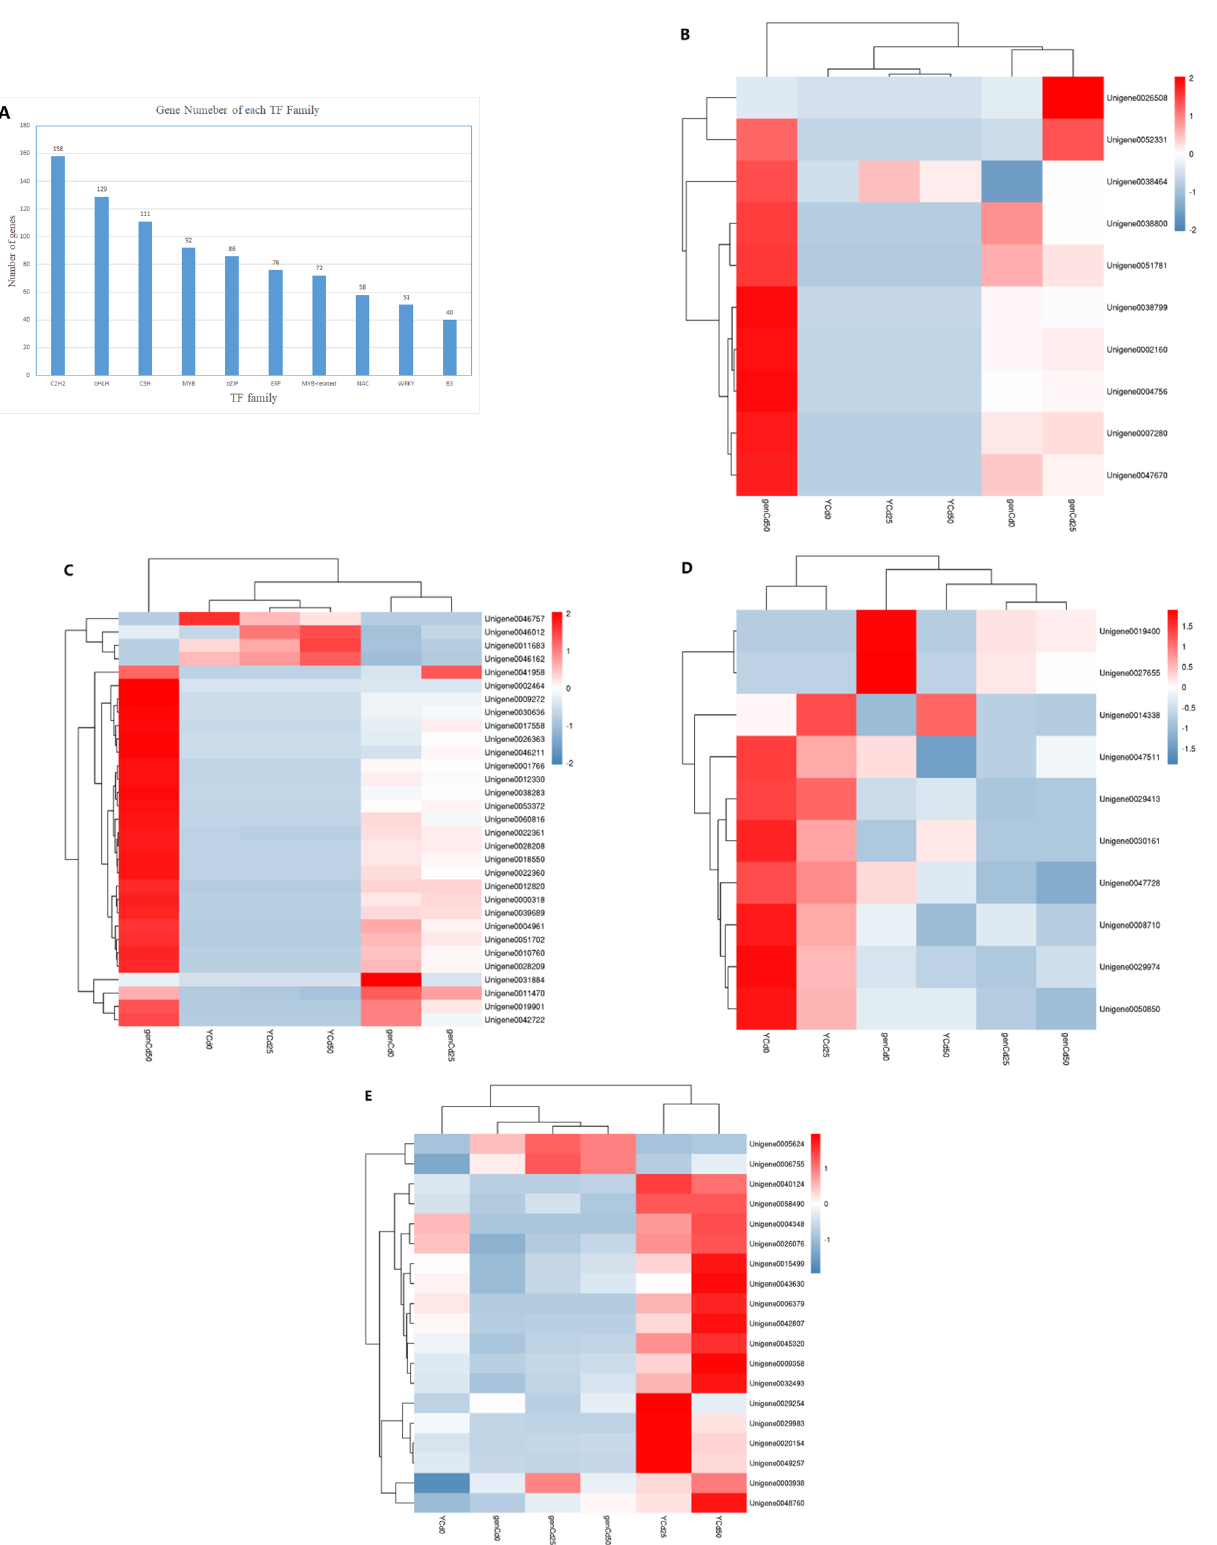
Figure 7. Transcription factor (TF) family analysis of goldenrain tree treated with 0 mg/L, 25 mg/L, and 50 mg/L CdCl 2 for 3 days. Y = leaves; gen = roots. ( A ) Gene number in different TF families. ( B – E ) Heat maps of expression profiles